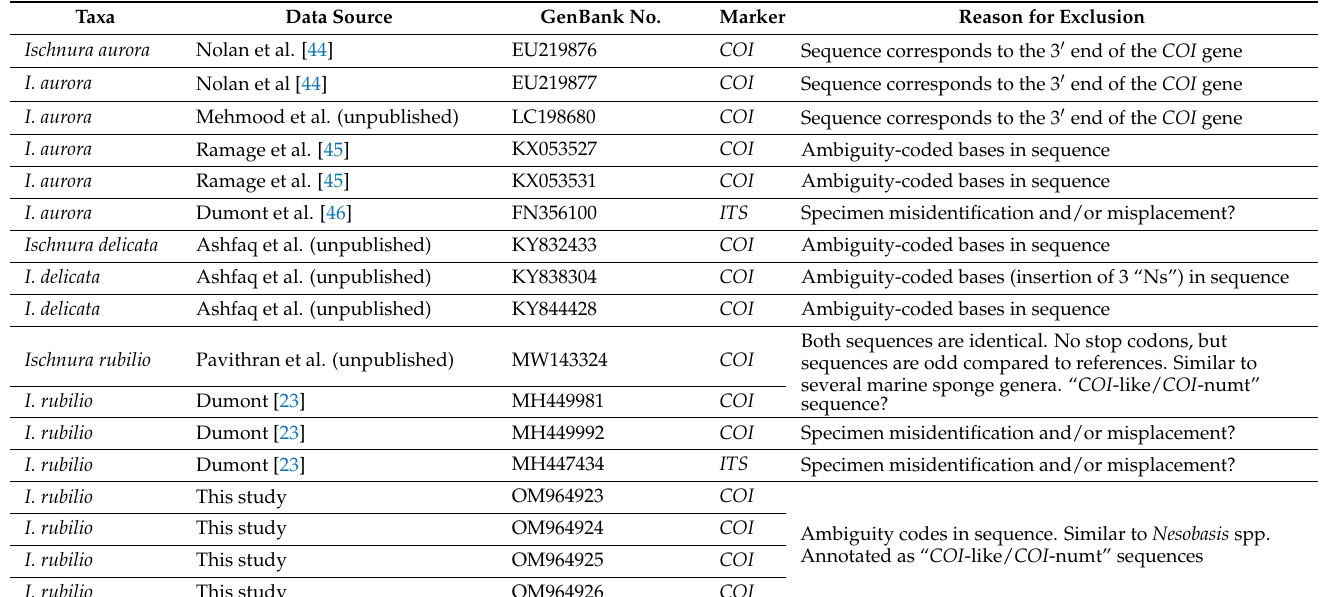
Table 2. Sequences of Ischnura aurora , I. delicata and I. rubilio that were excluded from the final genetic analyses after the quality control steps that are described in detail in the Appendix A, including the I. rubilio “ COI -like” sequences generated in this